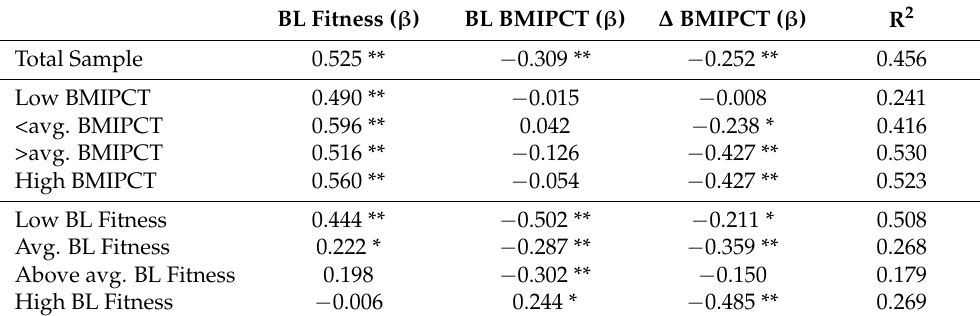
Figure 3. Cumulative prevalence of overweight/obesity throughout the observation period across quartiles of baseline physical fitness (Q1 indicates low physical fitness). Linear regression analyses further showed a significant negative association between change in BMIPCT and subsequent fitness (Table 3). The detrimental effect of higher weight gain on fitness development was particularly pronounced in participants with higher BMIPCT at baseline. No clear pattern of this association was observed across baseline fitness quartiles. The association between baseline fitness and fitness at the last follow ‐ up, however, was stronger in participants with lower baseline fitness. These results remained essentially unchanged after including sex as covariate. Table 3. Regression coefficients based on linear regression analysis for overall physical fitness at last measurement.